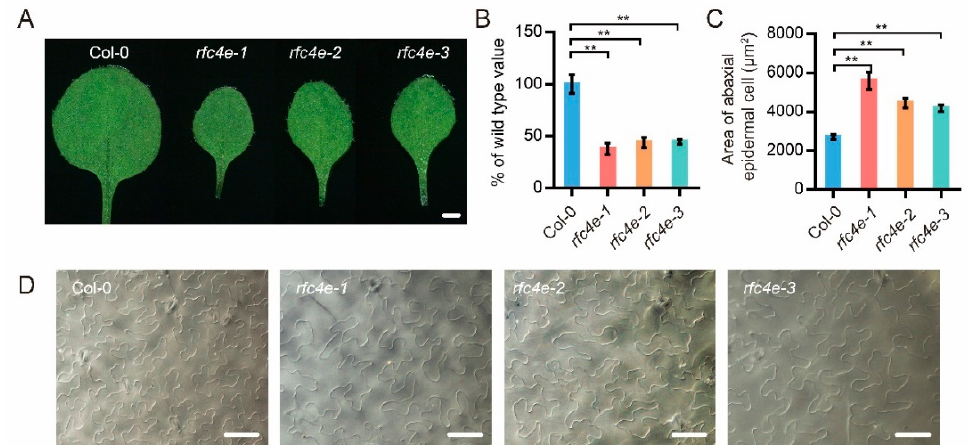
Figure 6. The AtRFC4 mutation leads to smaller leaves and enlarged lower epidermal cells. ( A ) The second true leaf of the wild type, rfc4e − 1 , rfc4e − 2 and rfc4e − 3 . Bar = 1 mm. ( B ) The average area of first to second true leaves of 18 − d − old seedlings of the indicated genotypes; data are compared to the Col − 0 value normalized at 100%. n ≥ 10. ( C , D ) The abaxial epidermal cells ( D ) and their average areas ( C ) of first to second true leaves of 18 − d − old seedlings of the indicated genotypes. Bar = 50 µ m. Error bars indicate ± SD (** p <